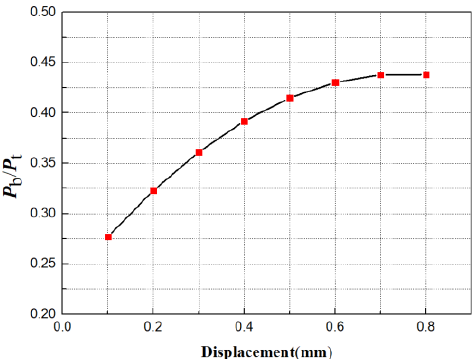
Figure 13. The variations in the ratio of the load shared by the bolt to the total load with displacement.